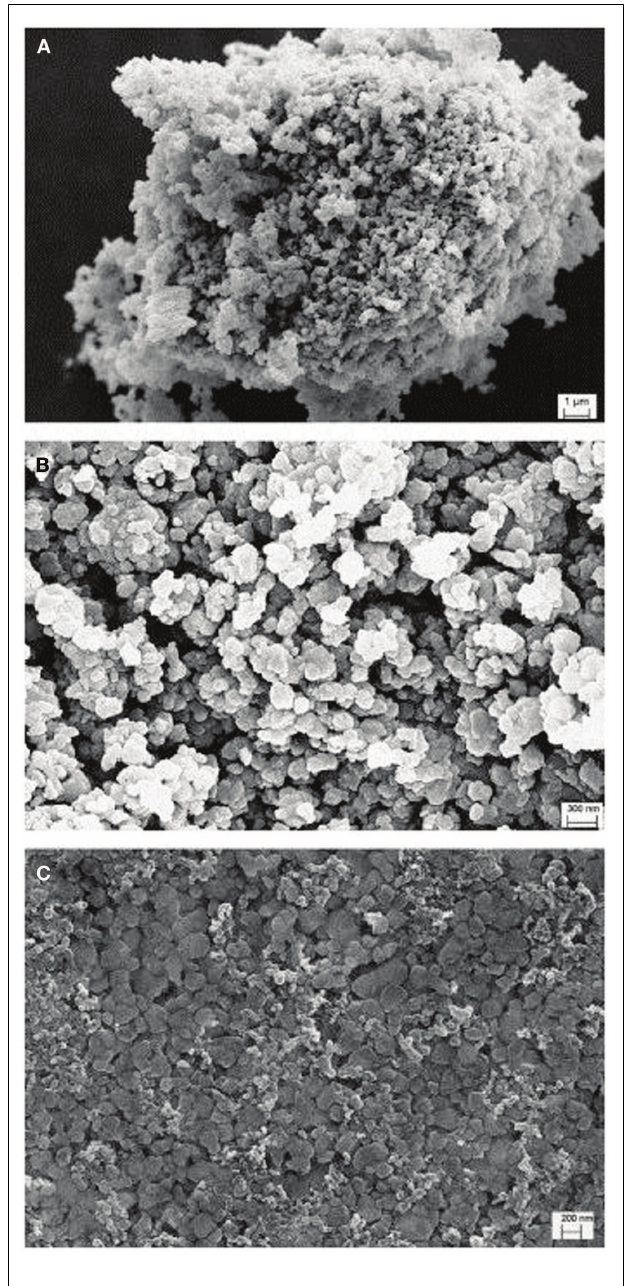
FIGURE 1 | SEM pictures of Li[Li 0.2 Mn 0.56 Ni 0.16 Co 0.08 ]O 2 materials at different magnifications . (A) × 5k; (B,C) × 50k. Reproduced with permission from Li et al.